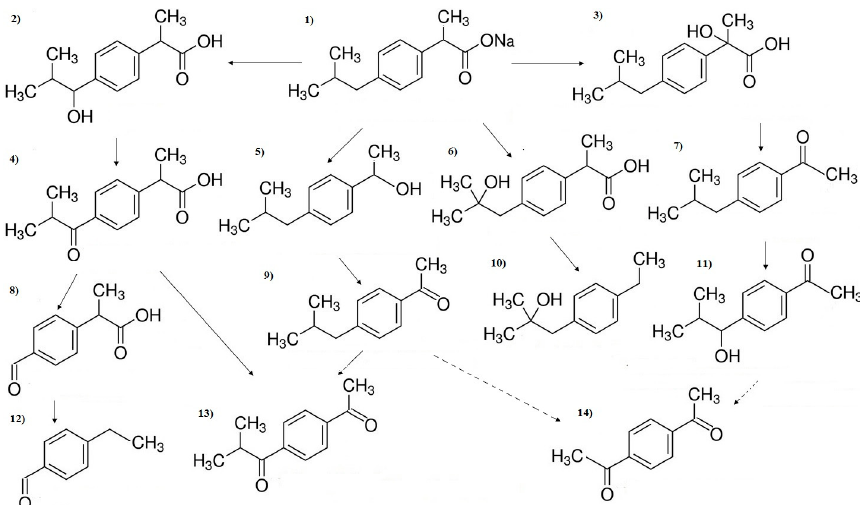
Figure 7. Possible degradation pathway of 1 ibuprofen sodium salt where 2 1 ‐ hydroxyibuprofen 3 2 ‐ hydroxy ‐ 2 ‐ [4 ‐ (2 ‐ methylpropyl)phenyl]propionic acid, 4 2 ‐ (4 ‐ isopropylcarbonylphenyl)propanoic acid, 5 1 ‐ (4 ‐ isobutylphenyl) ‐ 1 ‐ ethanol, 6 2 ‐ hydroxyibuprofen, 7 1 ‐ [4 ‐ (2 ‐ methylpropyl)phenyl] ethanone, 8 2 ‐ (4 ‐ formylphenyl)propanoic acid, 9 1 ‐ (4 ‐ isobutylphenyl) ‐ 1 ‐ ethanone, 10 1 ‐ ethyl ‐ 4 ‐ (2 ‐ hydroxy)isobutyl